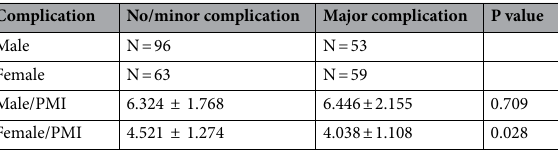
(Table 2). ROC curve analysis (Fig. 1) revealed a PMI cut-off point at 2.63 cm 2 /m 2 (sensitivity = 20.6%, speci- ficity = 92%, AUE = 0.567). Post-operative massive pleural effusion requiring pigtail drainage occurred more frequently in the sarcopenia group than in the non-sarcopenia group (P = 0.003).